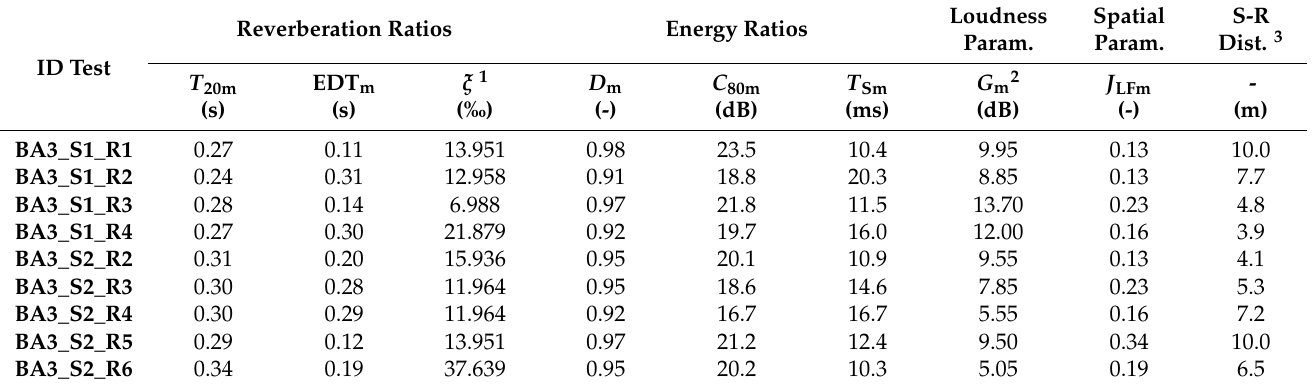
Loudness Spatial S-R Param. Param. Dist.